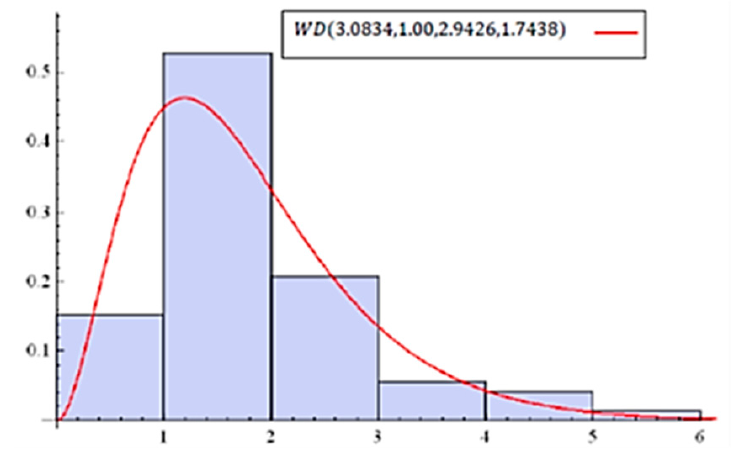
Figure 7. Estimated density of 𝑊𝐷(𝛼, 𝛽, 𝛾, 𝜆) for data set 3. The variance covariance matrix 𝐼(𝜃) (cid:2879)(cid:2869) of the MLEs under the Whittaker distribution for data set 4 is computed as follows.